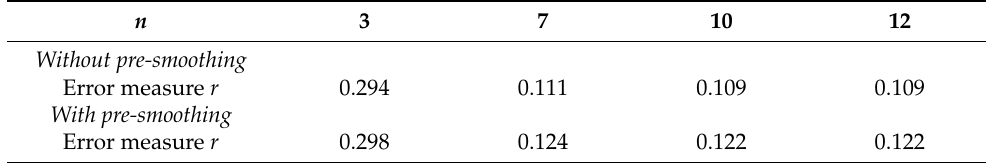
Table 2. Resulting error measure of the approximated storage and loss modulus.